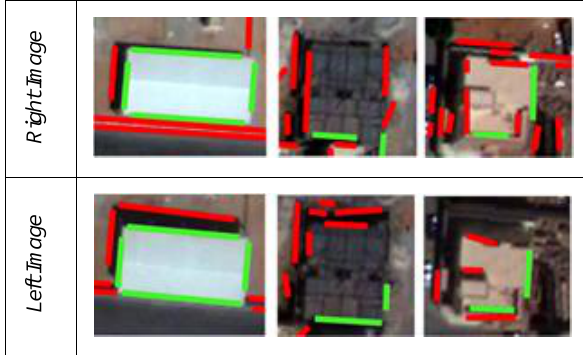
Figure 9. Sample of match (green) and un-match (red) straight lines, first building footprint on left side could be reconstructed but in the other two cases, only few line are matched.